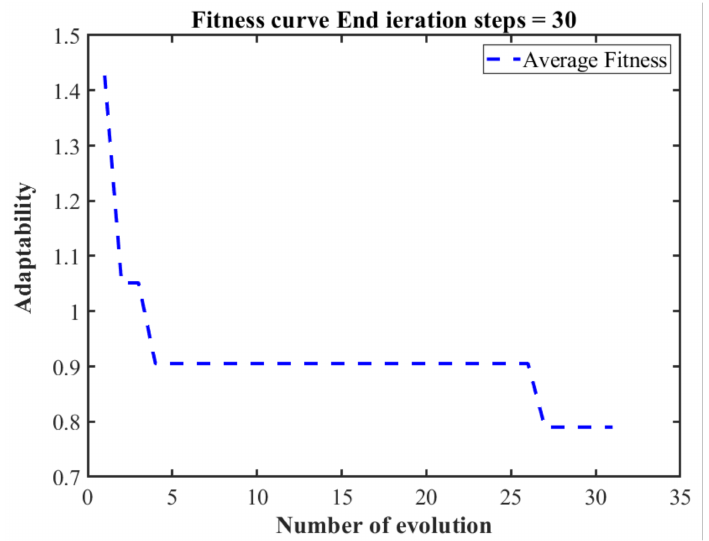
Figure 18. GA-BP Neural Network Application Curve.